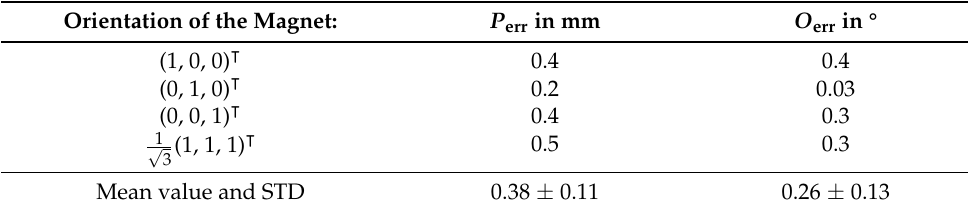
Table 4. Position P err and orientation O err errors and their mean value and standard deviation (STD)